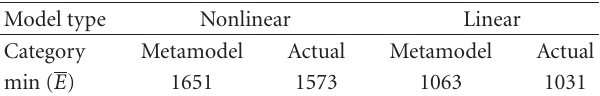
Table 9: Metamodel and Actual Result Comparison for PID